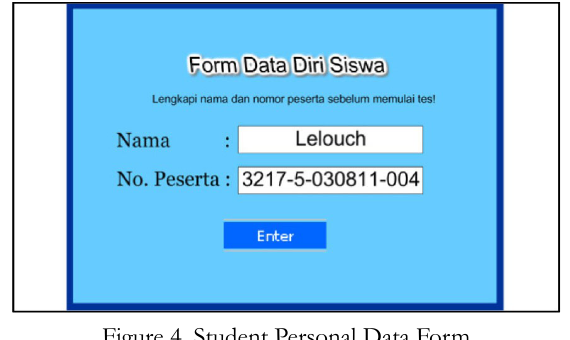
Figure 4. Student Personal Data